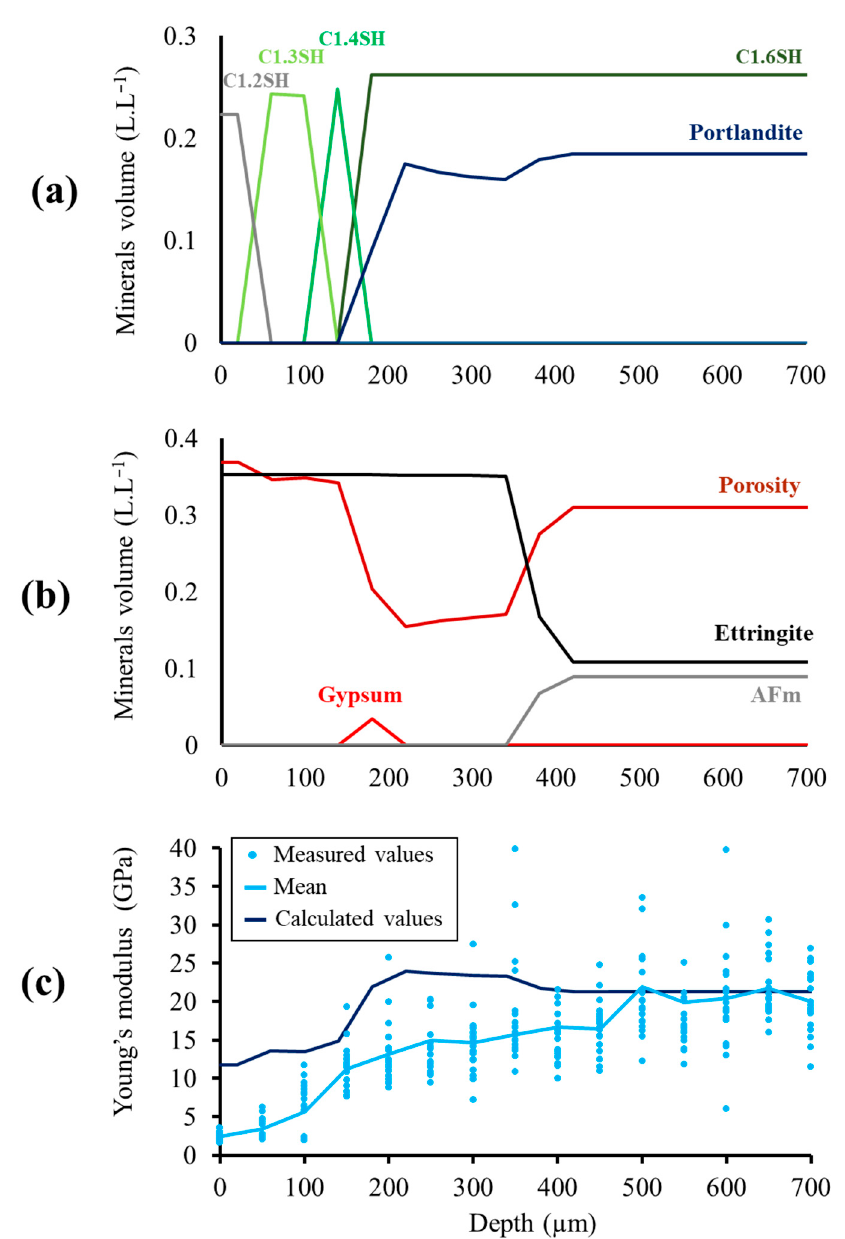
Figure 7. Calculated profiles of minerals and porosity obtained at 15 days ( a , b ) considered for calculating of Young’s moduli by homogenization ( c ).